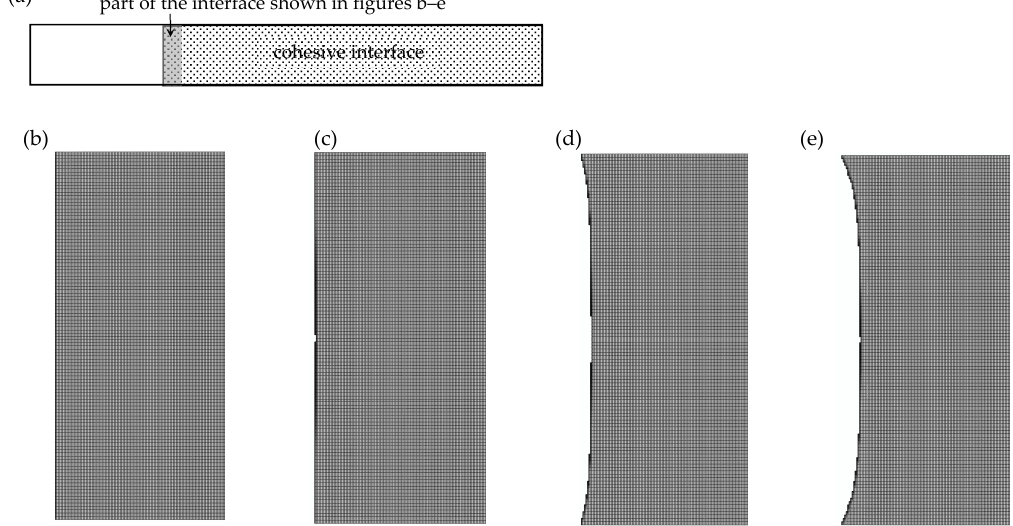
Figure 18. Shape at delamination front in Mode I simulation: ( a ) schematic of DCB specifying the part of the interface to be examined; ( b ) initial delamination front; ( c ) onset of delamination propagation; ( d ) delamination propagation towards the edges; ( e ) established delamination front.